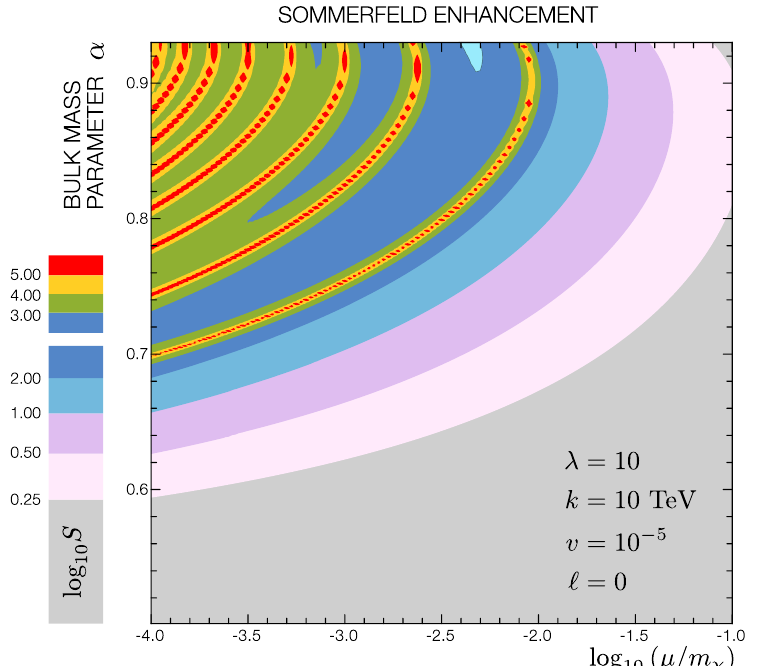
Figure 9 . Sommerfeld enhancement of the ‘ = 0 partial wave for a range of α and the ratio µ/m χ . Our approximation of the potential breaks down near α = 1 and hence this region is removed.